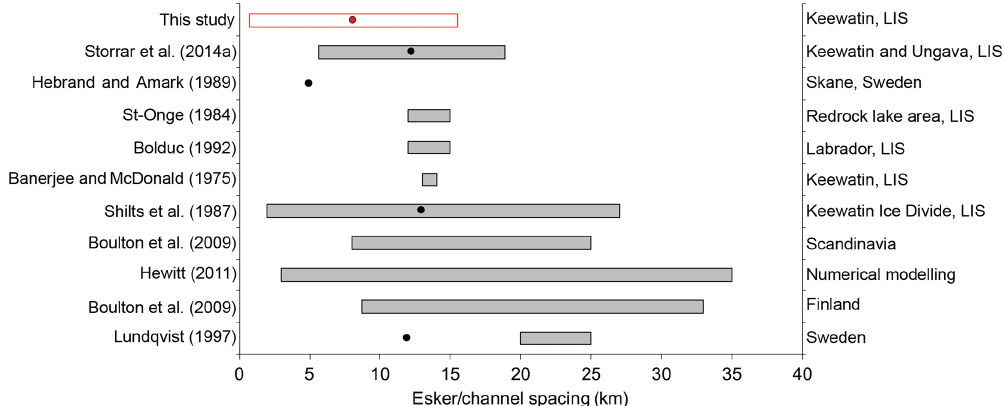
Figure 6. Examples of esker and subglacial channel spacing quoted in the literature with bars representing maximum and minimum and the points the mean (Storrar et al. 2014a). The top two bars represent a large-scale esker sample taken from an area which includes this study (Storrar et al., 2014a) and the spacing recorded by all visible traces of subglacial meltwater (i.e. eskers and meltwater corridors). For these two, the bars represent standard deviation and the points the mean. (Modified from Storrar et al., 2014a).